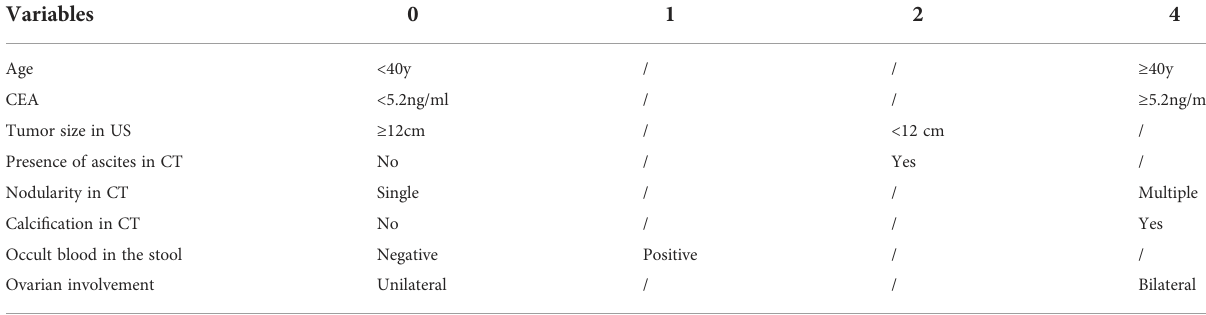
TABLE 4 A pre- and intraoperative clinical characteristics scoring system for differentiating AMNs from POMTs.